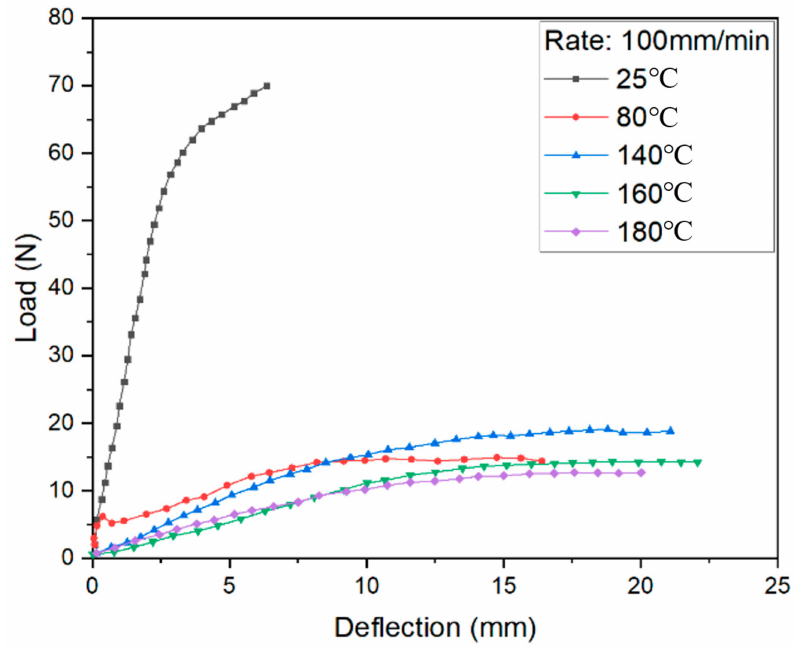
Figure 10. Load-displacement curves and fitting surface under 100 mm/min loading